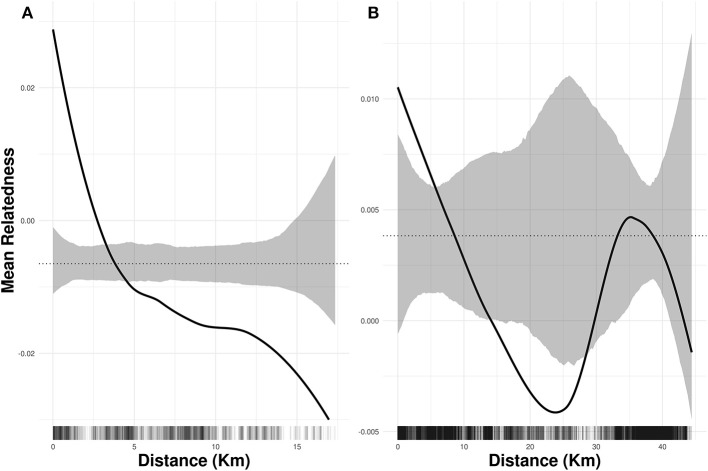
Spatial autocorrelation in genetic relatedness for I. cavalcantei
(A) and I. maurandioides
(B). The black solid lines are the LOESS fit to the observed relatedness, while the grey shaded regions are 95% confidence bounds around the null expectation (black dotted lines). Short vertical lines at the bottom of each figure are observed pairwise distances.